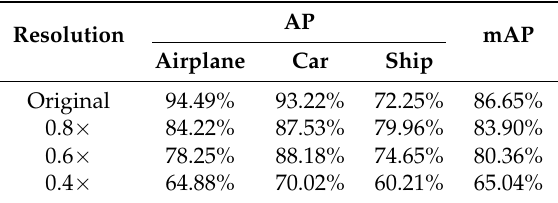
Table 4. Impact of different resolutions on performance.